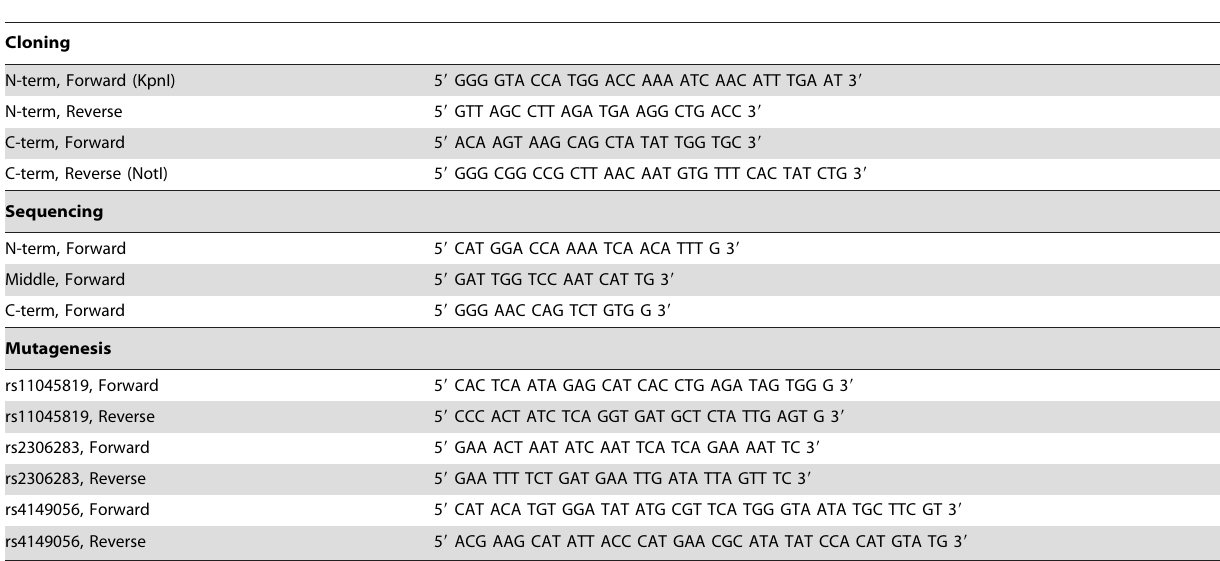
Table 2. List of primers used for cloning, sequencing, and mutagenesis of SLCO1B1.